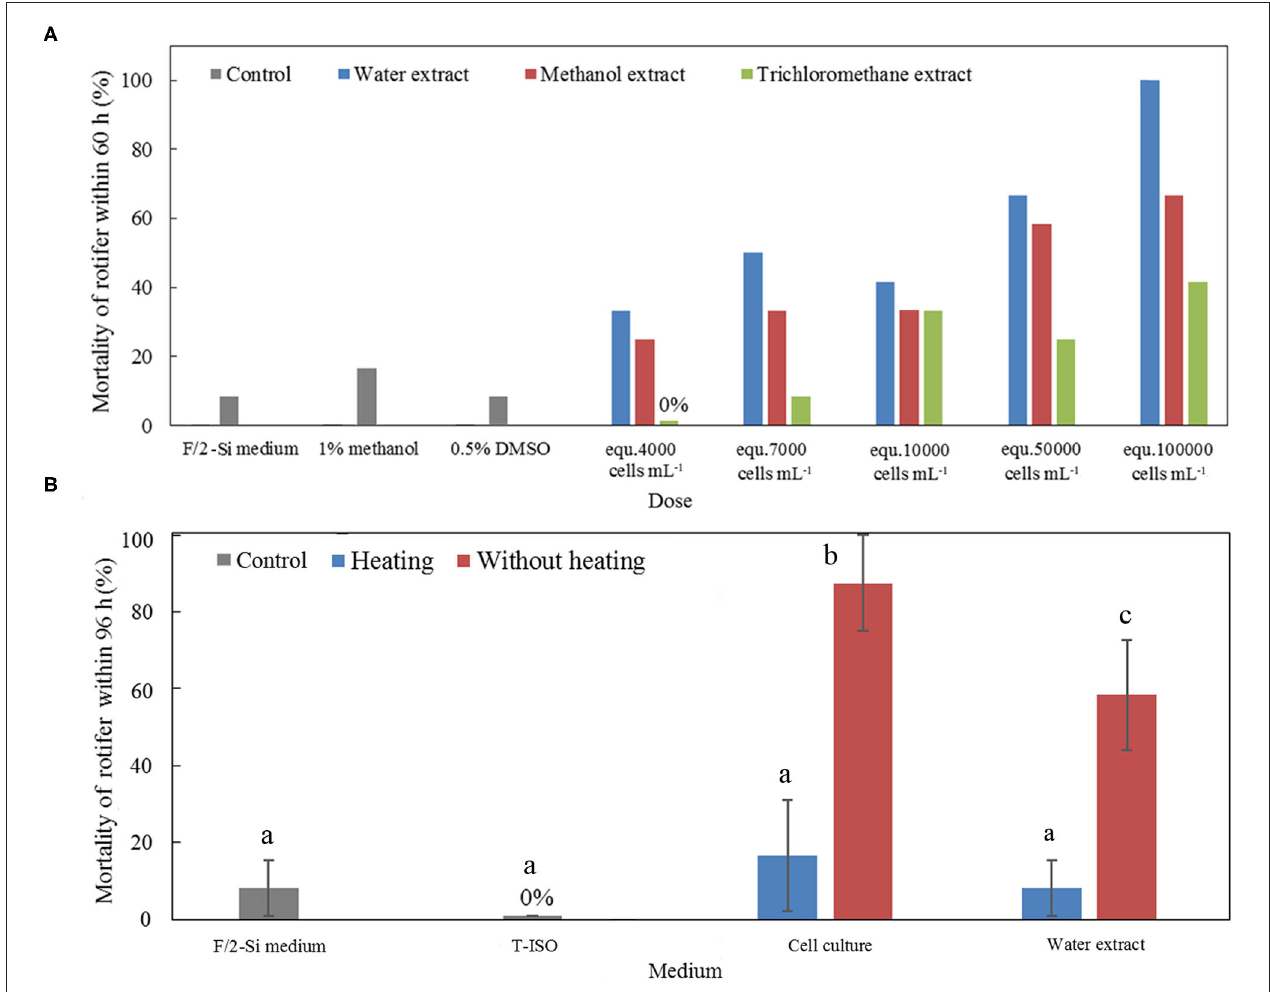
FIGURE 8 | (A) Mortality of rotifer in the bioassays of toxin extracts using three solvents with different polarities (water, methanol, and trichloromethane). F/2-Si culture medium, with and without addition of 1% methanol or 0.5% dimethylsulfoxide, were used as negative controls. (B) Mortality of rotifer in the bioassays using both heat-killed cell cultures and heated water extracts. The same cell cultures and water extracts of A. insuetum without heating were used as positive controls, f/2-Si medium and Isochrysis galbana algal culture (T-ISO) were used as negative controls. The error bars indicate ± 1 SD, and different superscript letters (a, b, and c) showed significant differences between different treatments ( p < 0.05,